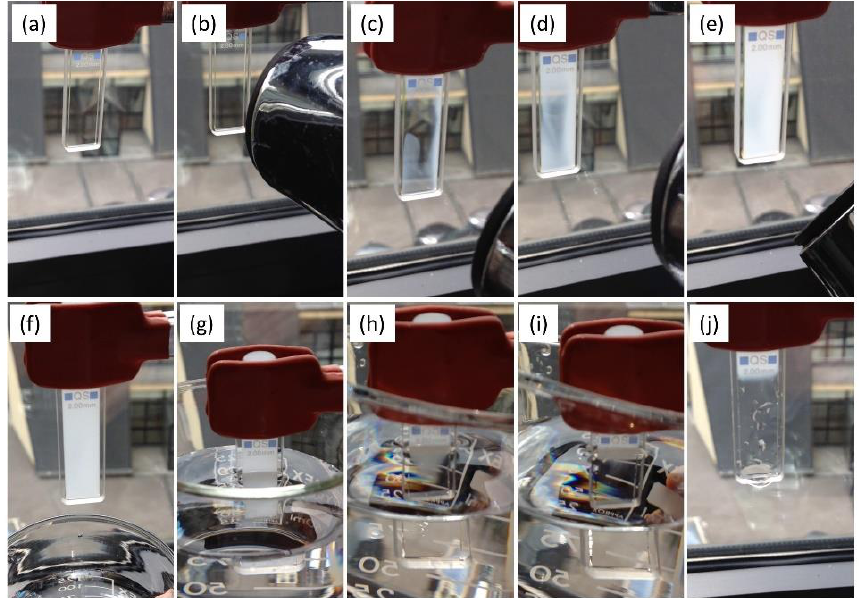
Figure 1. Representative cellulose ether aqueous solution during the heating cycle (frames ( a ) – ( e )) and during reverse cooling process (frames ( f ) – ( j )).